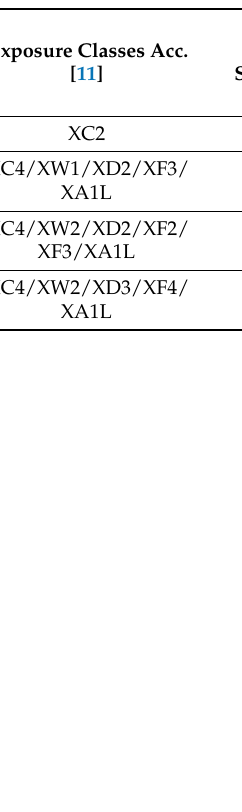
Table 1. Concrete formulations for investigating the properties of fresh and hardened concrete